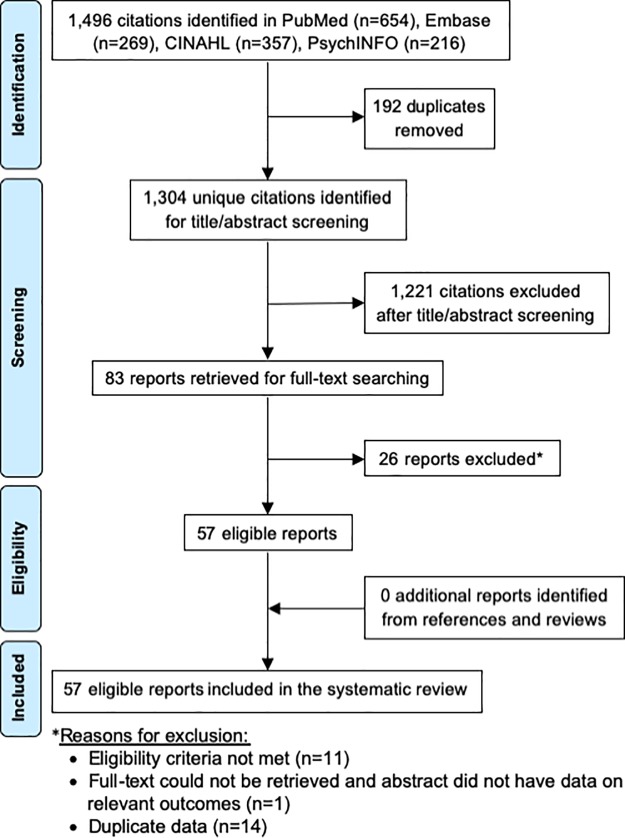
Flow diagram of article selection.